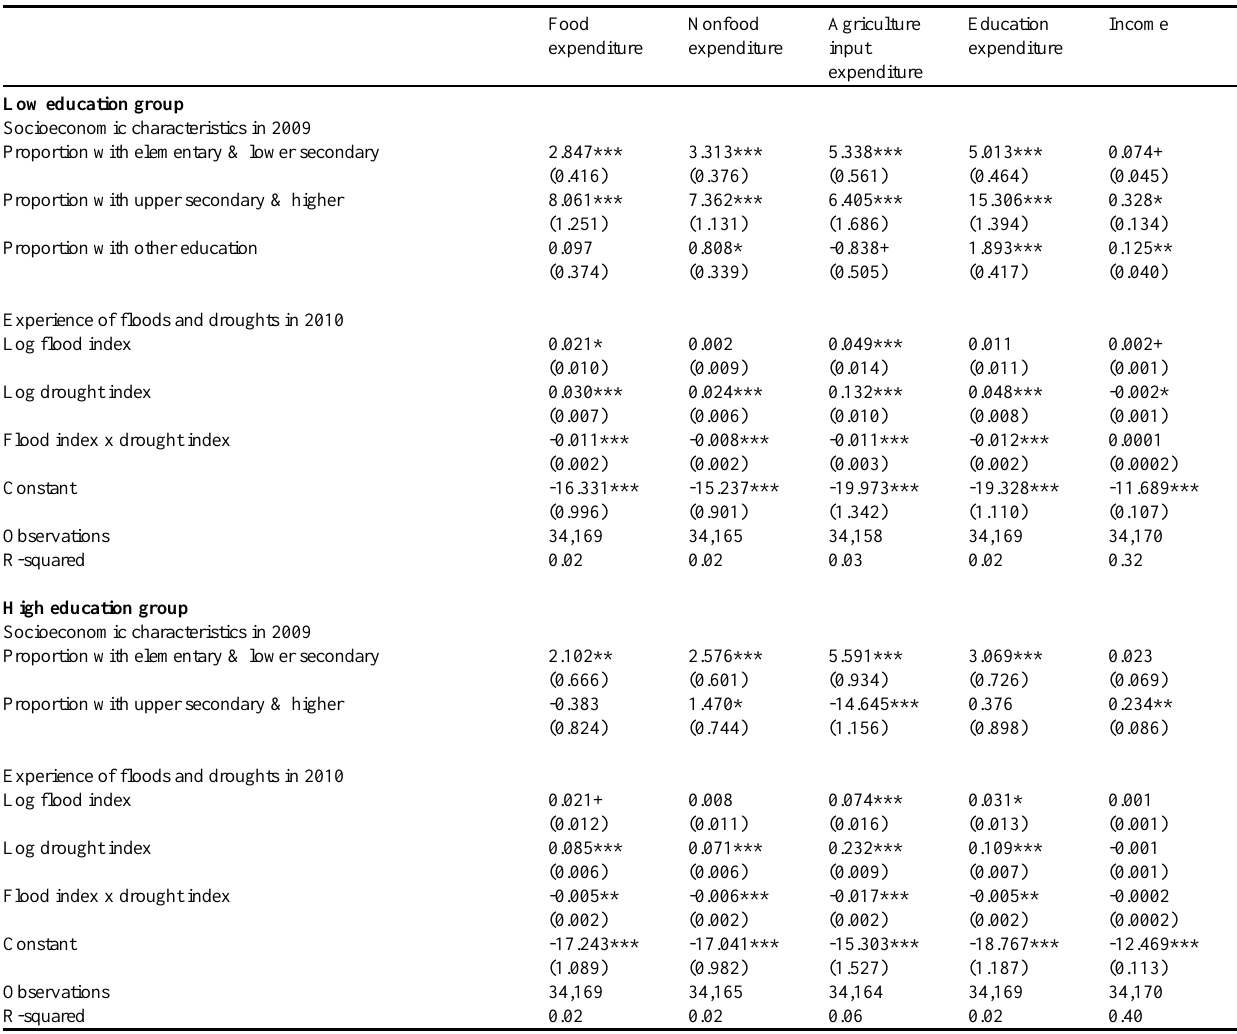
Table 4 . Difference-in-difference estimates of community welfare (standard errors in parentheses) † : splitting sample into low and high education groups ‡